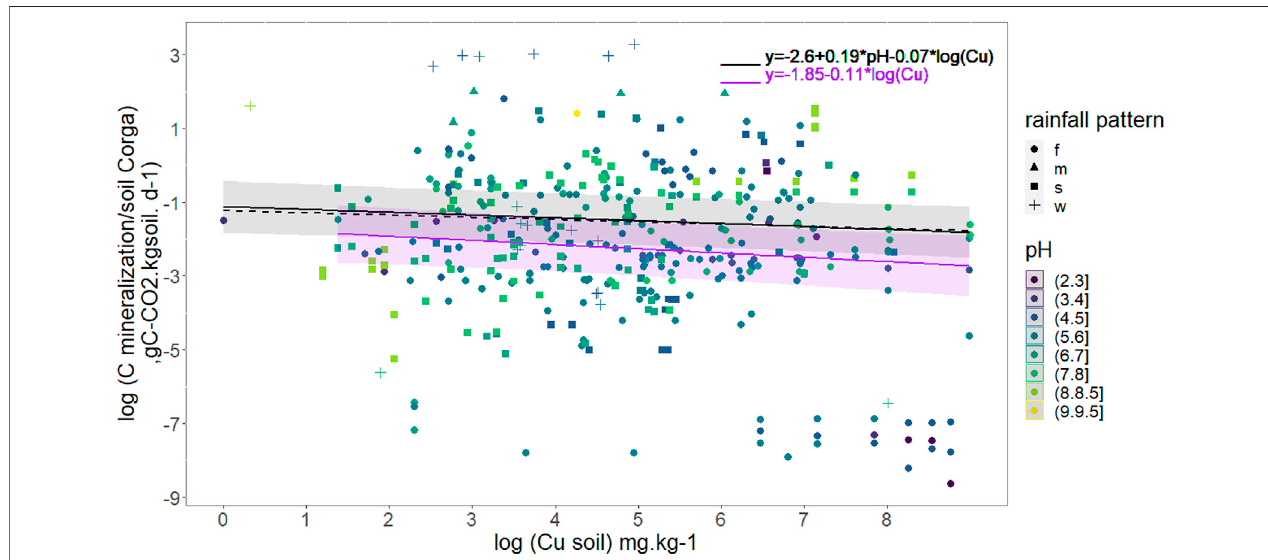
FIGURE 2 | Daily Soil C mineralization per g organic C per day as a function of soil Cu concentration. Soil pH is colored scale and rainfall pattern represented with point shape. The full black linemodels copper effect on daily mineralization for all data considering median pH (5.9), R 2 (cid:2) 0.90. The black dash line models copper effect ondailymineralizationfordatawithpH < 5.3.ThepurplelinemodelscoppereffectondailymineralizationfordatawithpH Є [5.3,7].Theshadedareaare95%con fi dence interval for all data in black and data with pH Є 05.3,7] in purple. Rainfall patterns are the following: f (cid:2) humid all year long, m (cid:2) monsoon, s (cid:2) dry summer, w (cid:2) dry